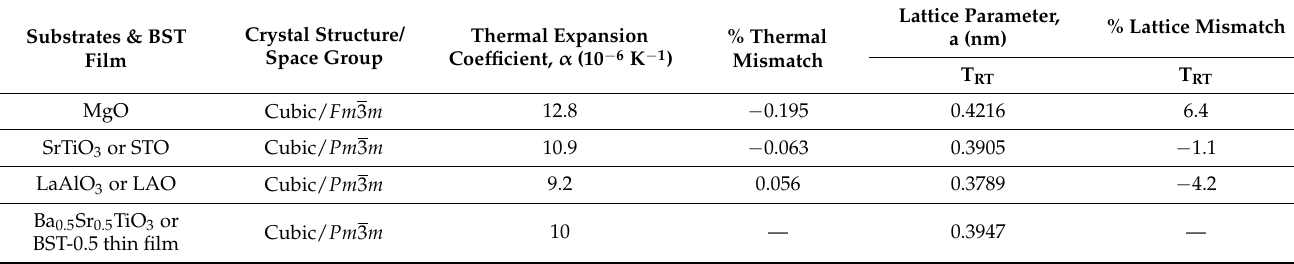
Table 1. Properties and parameters of isotropic substrates and a freestanding (or unconstrained) cubic BST-0.5 film with estimated percent strains due to film-substrate lattice mismatch at T RT = 25 ◦ C and T Dep = 720 ◦ C, and film-substrate thermal expansion